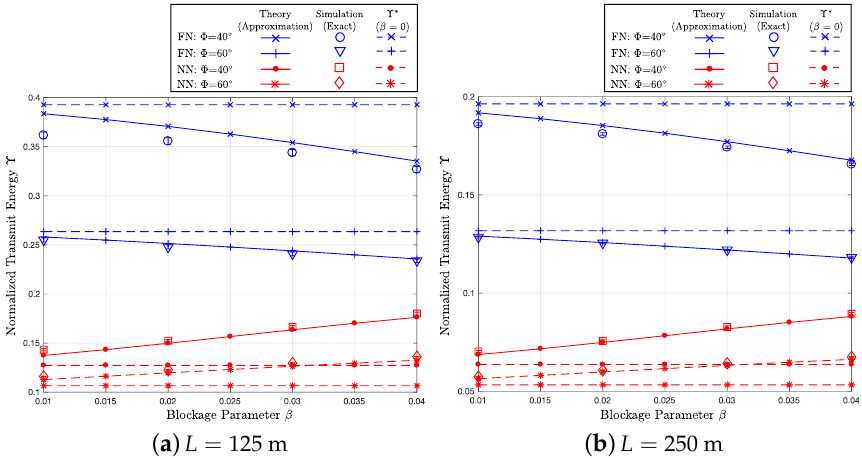
Figure 7. Υ versus β with λ = 0.015, Φ = { 40 ◦ ,60 ◦ } , and R = { 50 m, 33.3 m }